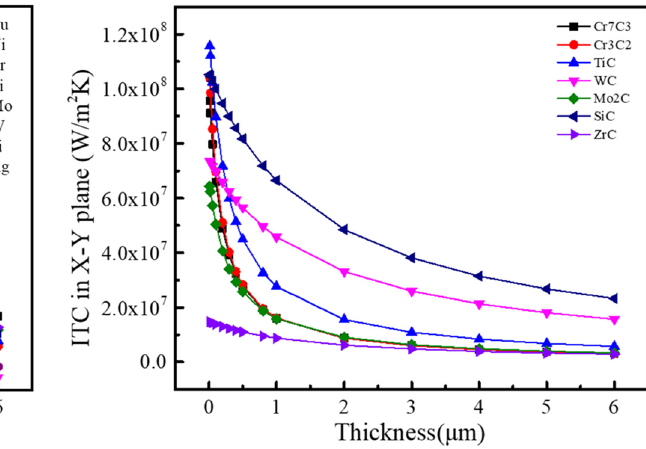
Figure 3: ITC of graphite fl akes/Al composites with typical metal coatings as a function of coating thickness.